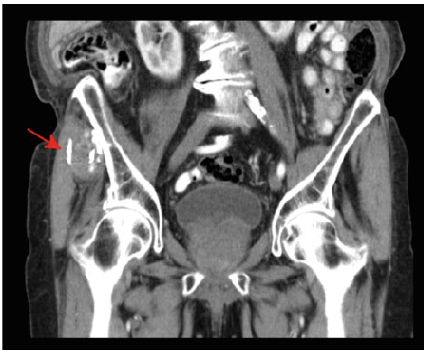
Figure 2: CT scan (coronal view) of the patient ’ s abdomen and pelvis demonstrating radiopaque surgical material adjacent tothe right ilium.